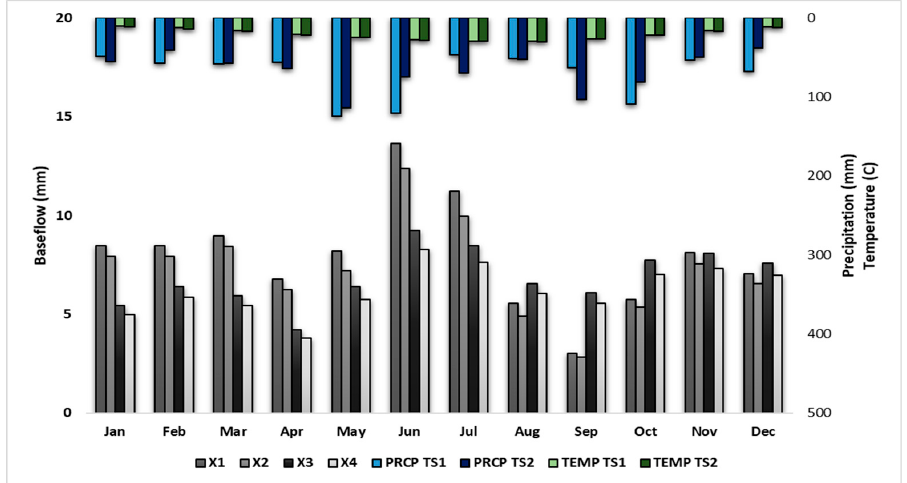
Figure 14. Monthly baseflow change for the Walzem Creek watershed under different scenarios.